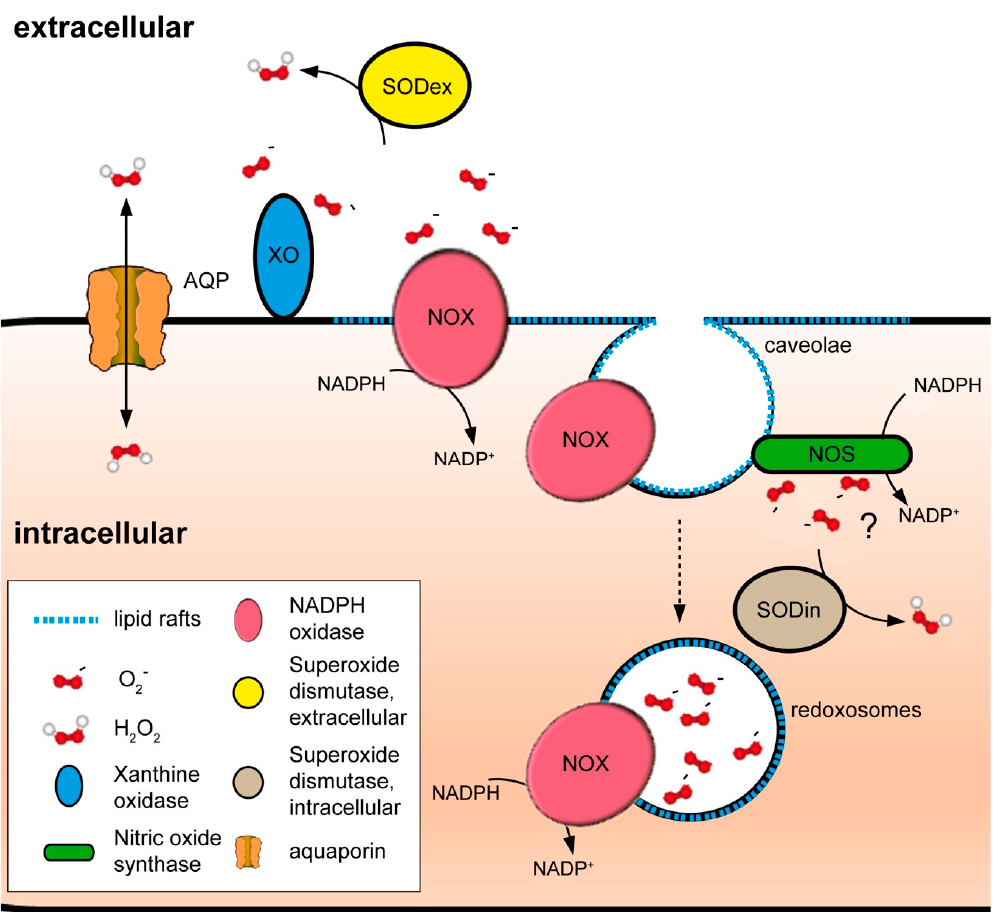
Figure 3. Cellular factors of plasma membrane redox signaling. As integral membrane proteins, NADPH oxidases (NOX, dark pink) are present either on lipid rafts (dashed blue line) or in caveolae,